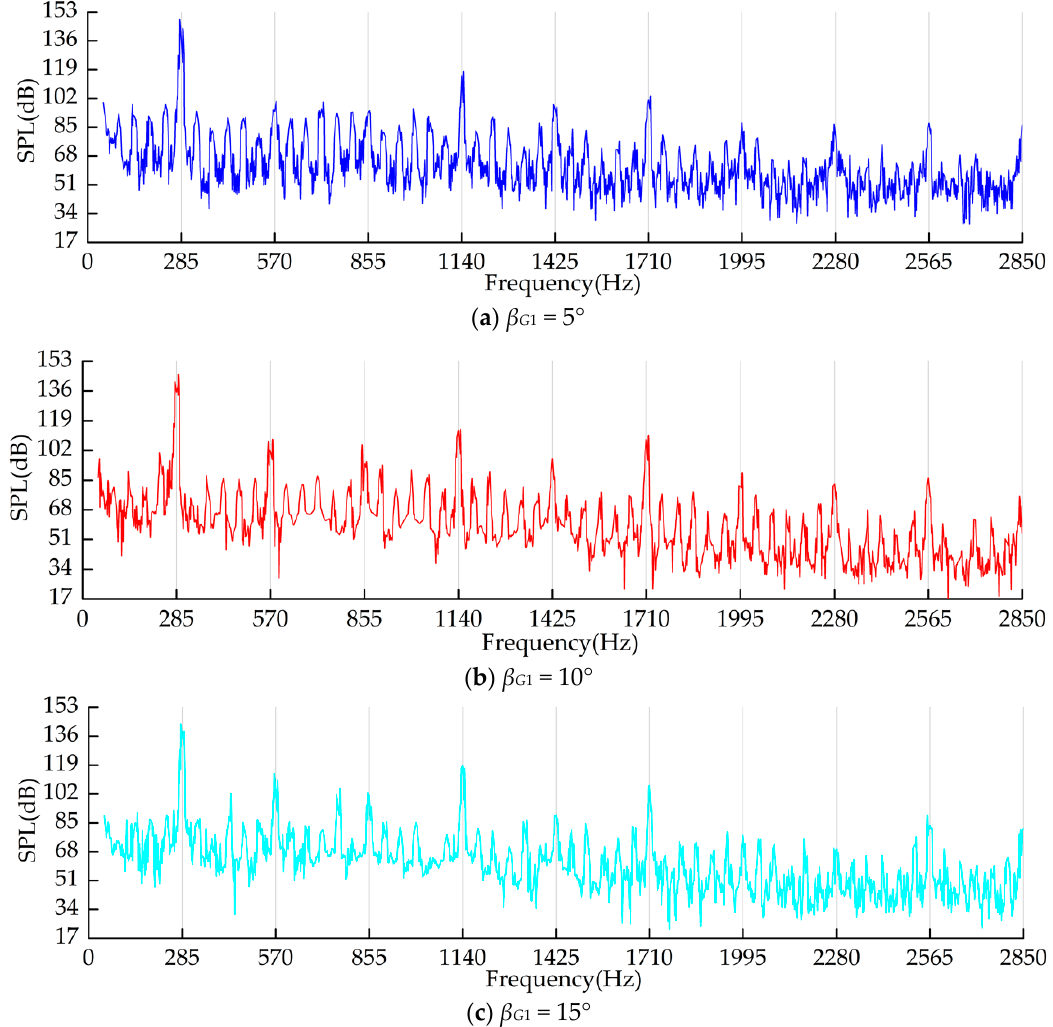
Figure 20. Frequency response curves of the SPL inside the impeller with different inlet angles of the positive guide vane.